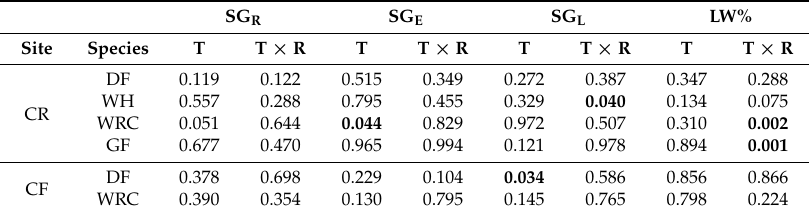
Table 3. Adjusted p -value from the time-series ANOVA test of fixed effects for treatment (T) and the interaction-effect treatment × ring (T × R) regarding ring specific gravity (SG R ), earlywood specific gravity (SG E ), latewood specific gravity (SG L ) and latewood percent (LW%), for Douglas-fir (DF), western hemlock (WH), western redcedar (WRC), and grand fir (GF) trees growing under contrasting vegetation management treatments on sites located in the Cascade Foothills (CF) and the central Coast Range (CR) of western Oregon. Bold : result is statistically significant at p < 0.05 or p < 0.01. SG R SG E SG L LW% Site Species